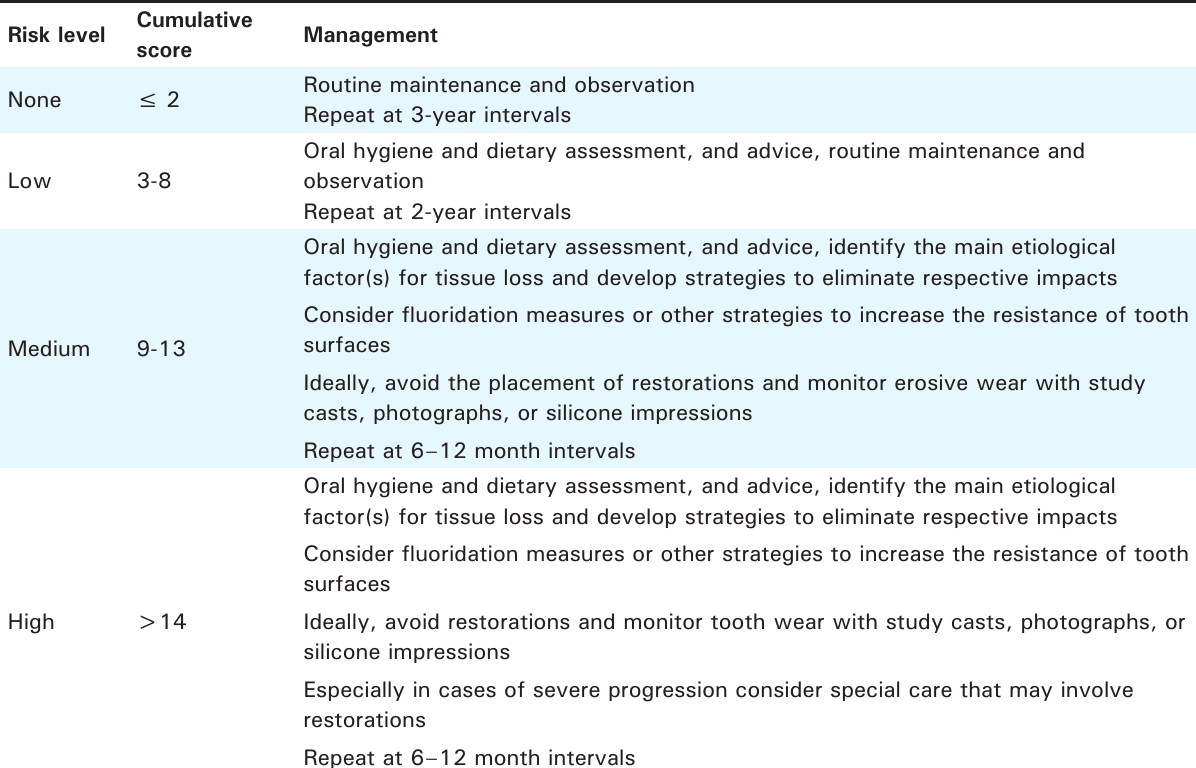
Table 2. Risk levels as a guide to clinical